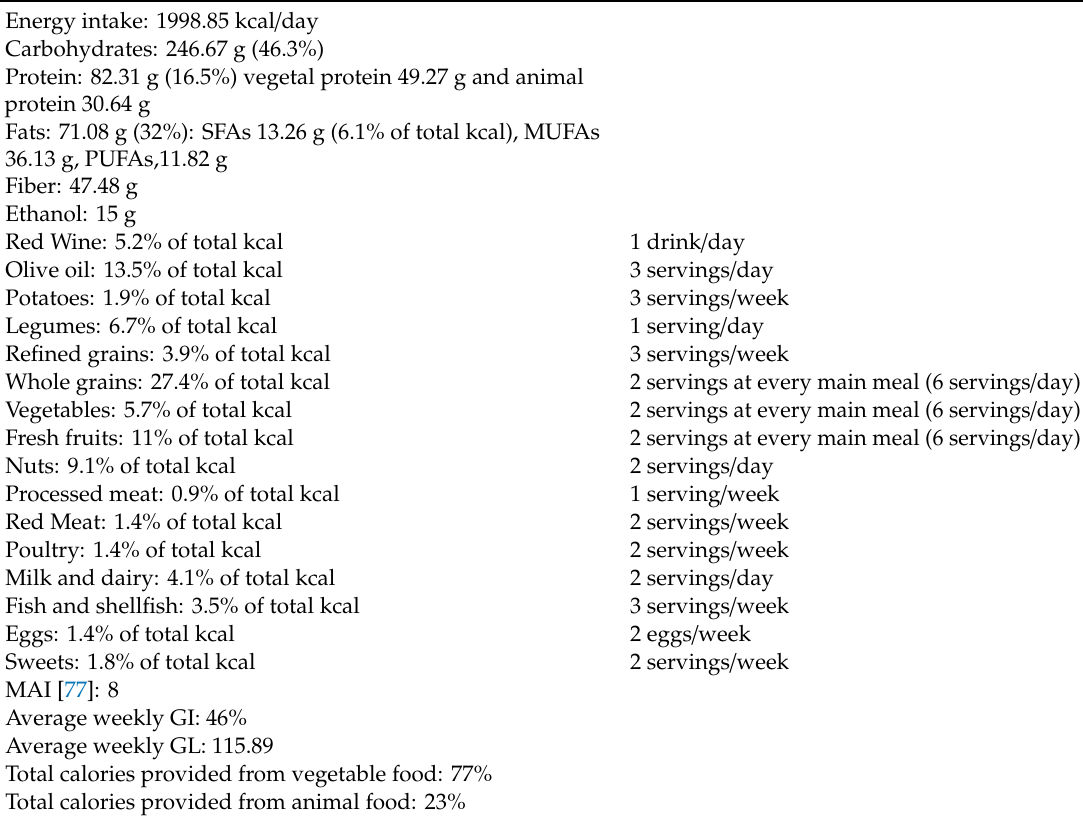
Table 18. Nutritional composition (mean of 7 days) and number of servings of weekly menu plan built on advice of Mediterranean Diet Pyramid for Italian